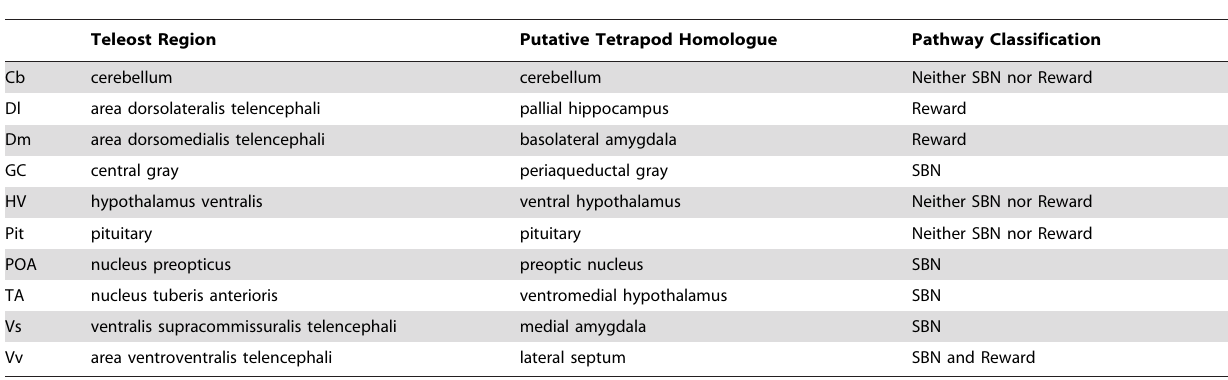
Table 1. Brain region terminology, putative tetrapod homologue and pathway